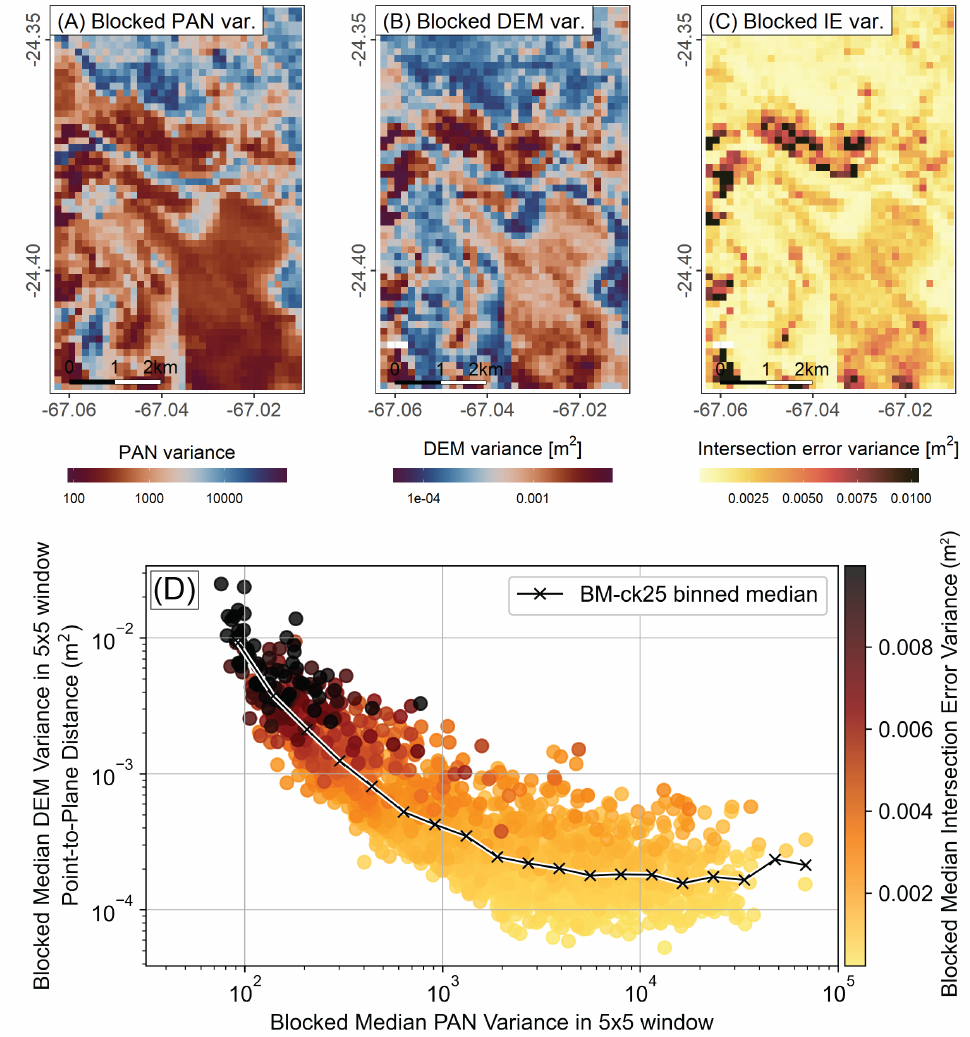
Figure 7. ( A ) 5 × 5 pixel windowed PAN variance and ( B ) 5 × 5 pixel windowed DEM variance for the SPOT6 BM-ck25 3 m DEM, both blocked into 50 × 50 pixel (150 × 150 m) areas, with the median value in each block given by the color scale; ( C ) the same 5 × 5 pixel variance calculation and blocking carried out on the intersection error output from the ASP; ( D ) the blocked variables in ( A ) and ( B ) plotted against each other and colored by ( C ), with a binned median taken through all ∼ 2400 blocks.